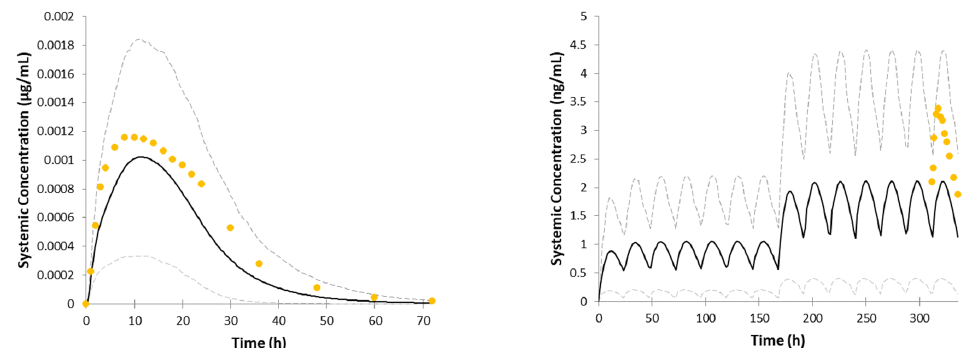
Figure 3. Mean observed (circles) and simulated (solid line) systemic plasma concentration–time profiles of ropinirole. Variability of the observed data is provided as SD if reported in the study; 5%th and 95%th percentiles are presented as grey dashed lines. Design of studies is provided in Table 2. Each Latin letter in this figure is a reference to the Simulation ID in Table 2. Multiple dose simulations additionally zoomed (e.g., f–n zoomed) in the time period where the observed data was available.